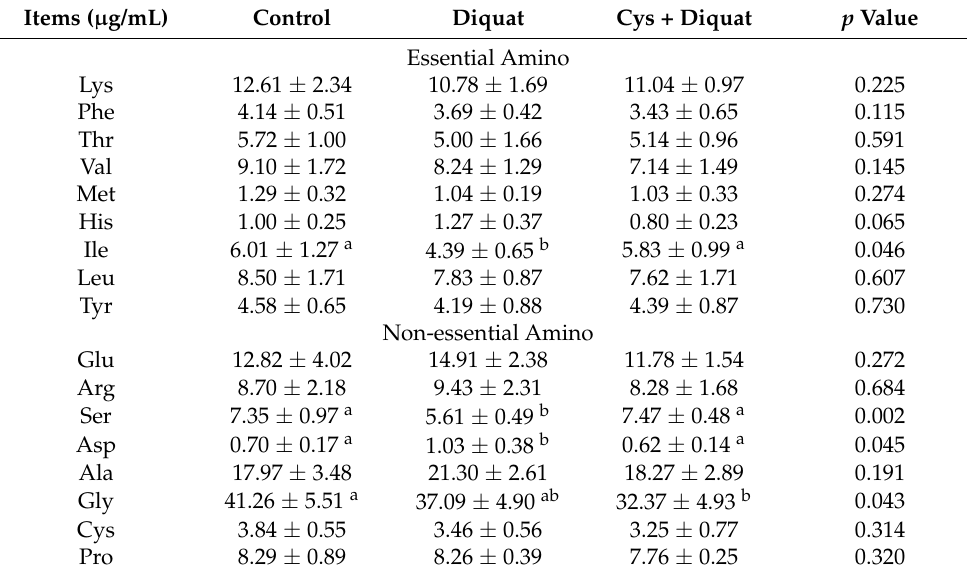
Table 5. Effect of dietary supplementation of coated cysteamine on serum amino acids in pigs induced by diquat.